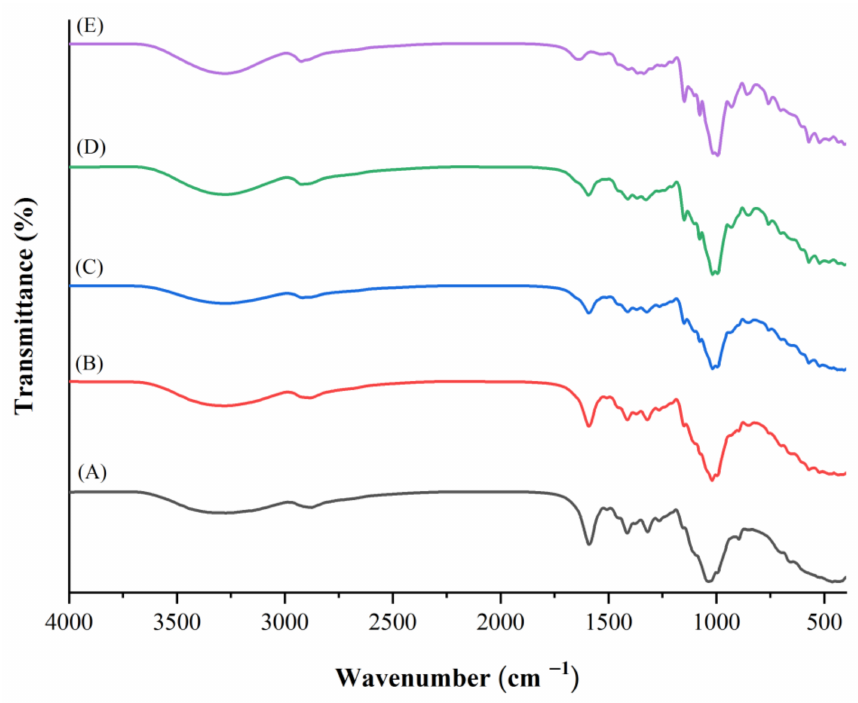
Figure 5. FTIR spectra of ( A ) CMCy film, ( B ) CMCy75/RF25 composite film, ( C ) CMCy50/RF50 composite film, ( D ) CMCy25/RF75 composite film, and ( E ) RF